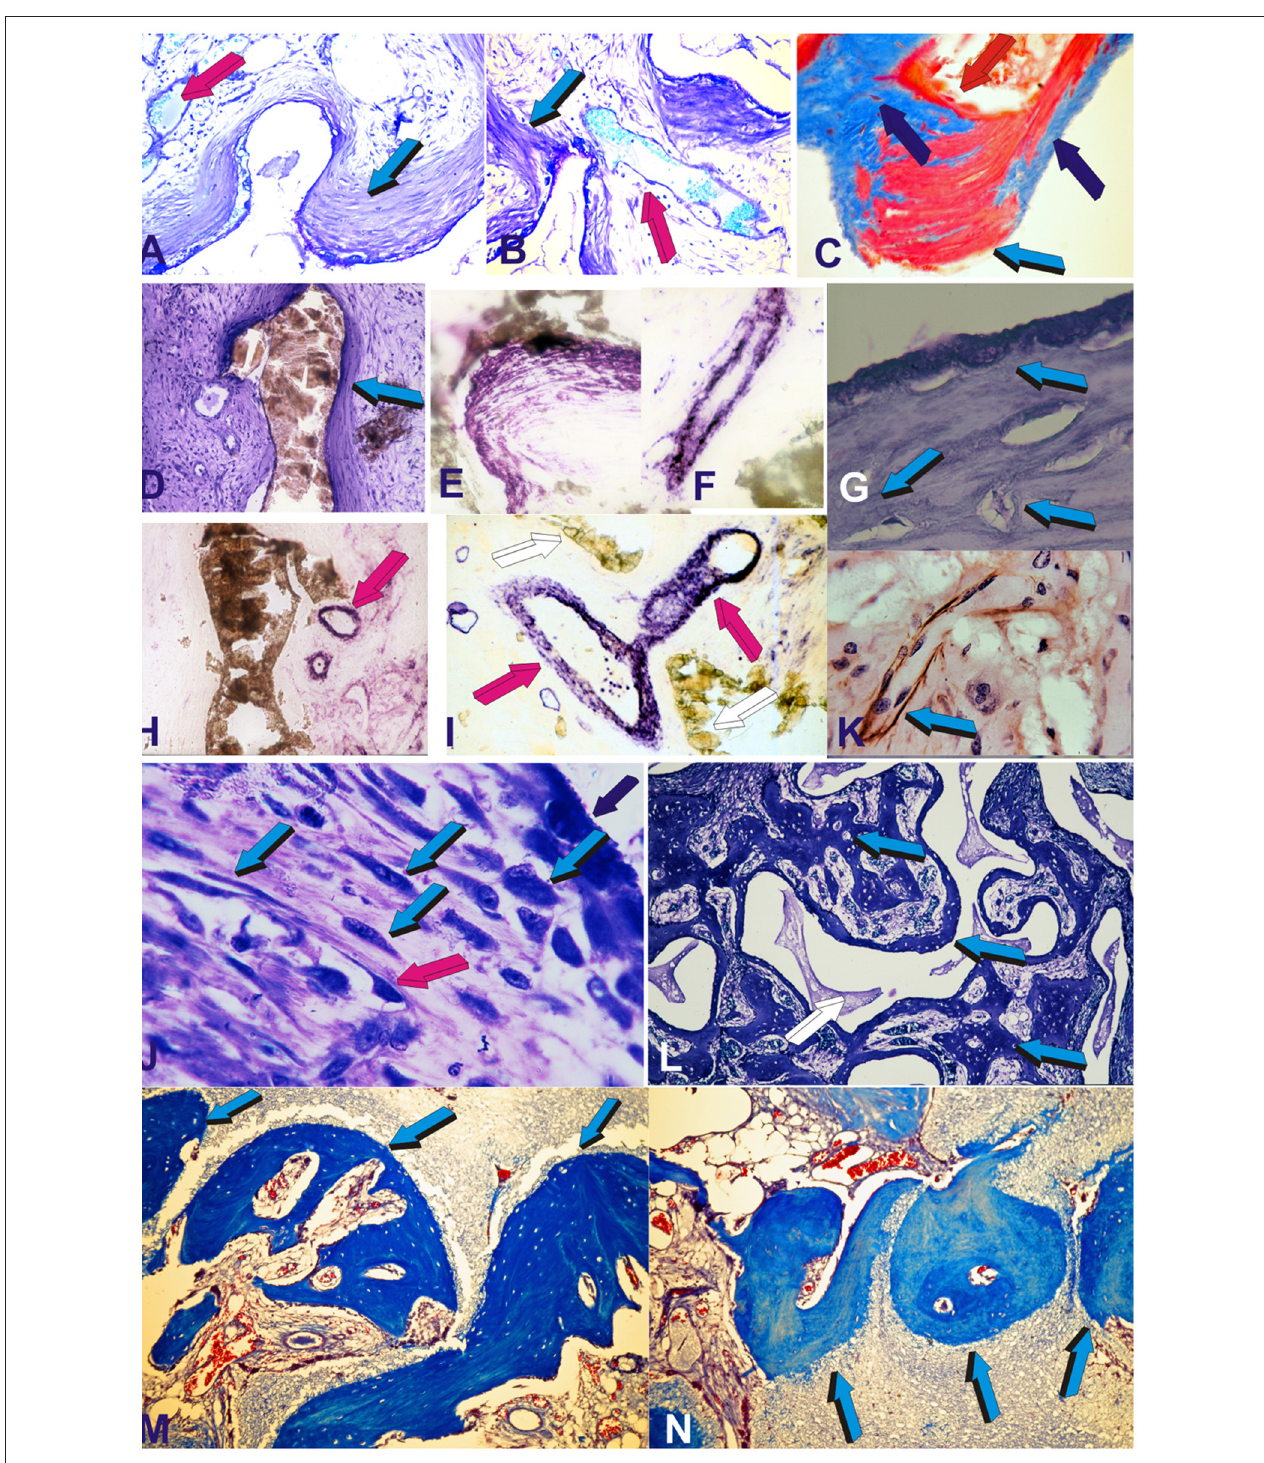
FIGURE 1 | Self-inducing geometric cues and the induction of tissue patterning, morphogenesis with the final induction of bone formation as initiated by the geometric concavities of the coral-derived calcium phosphate based macroporous bioreactors. Coral-derived macroporous bioreactors, 20mm in height and 11mm in diameter, were implanted in heterotopic intramuscular rectus abdominis sites in a series of non-human primate Chacma baboon Papio ursinus . Generated tissues were harvested on day 30, 60, and 90 after heterotopic implantation (Ripamonti, 1990, 1991, 1996; Ripamonti et al., 1993, 2009, 2010; van Eeden and Ripamonti, 1994). Harvested tissues were processed for decalcified and undecalcified histological analyses. (A–D) Tissue patterning and the induction of mesenchymal tissue